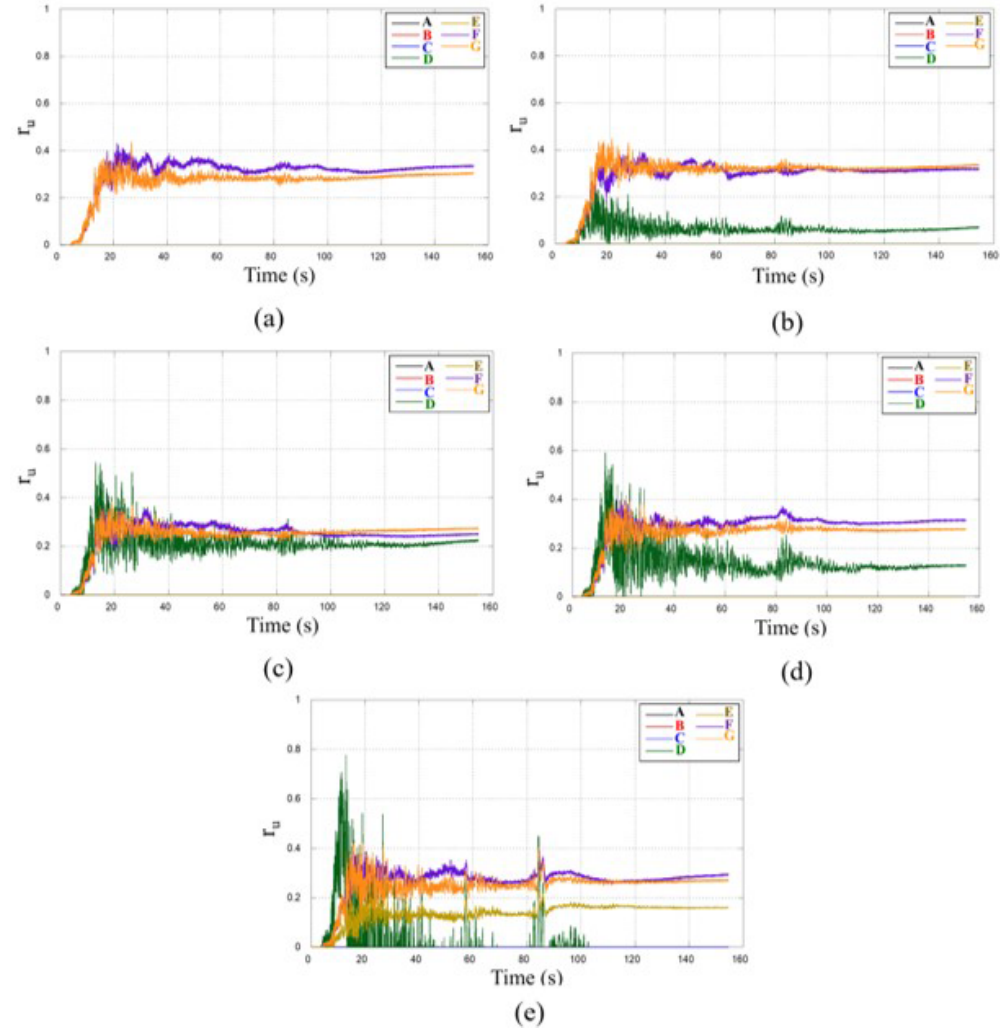
Figure 22. Variations in pore pressure ratios in scenarios (a) 1, (b) 2, (c) 3, (d) 4 and (e)